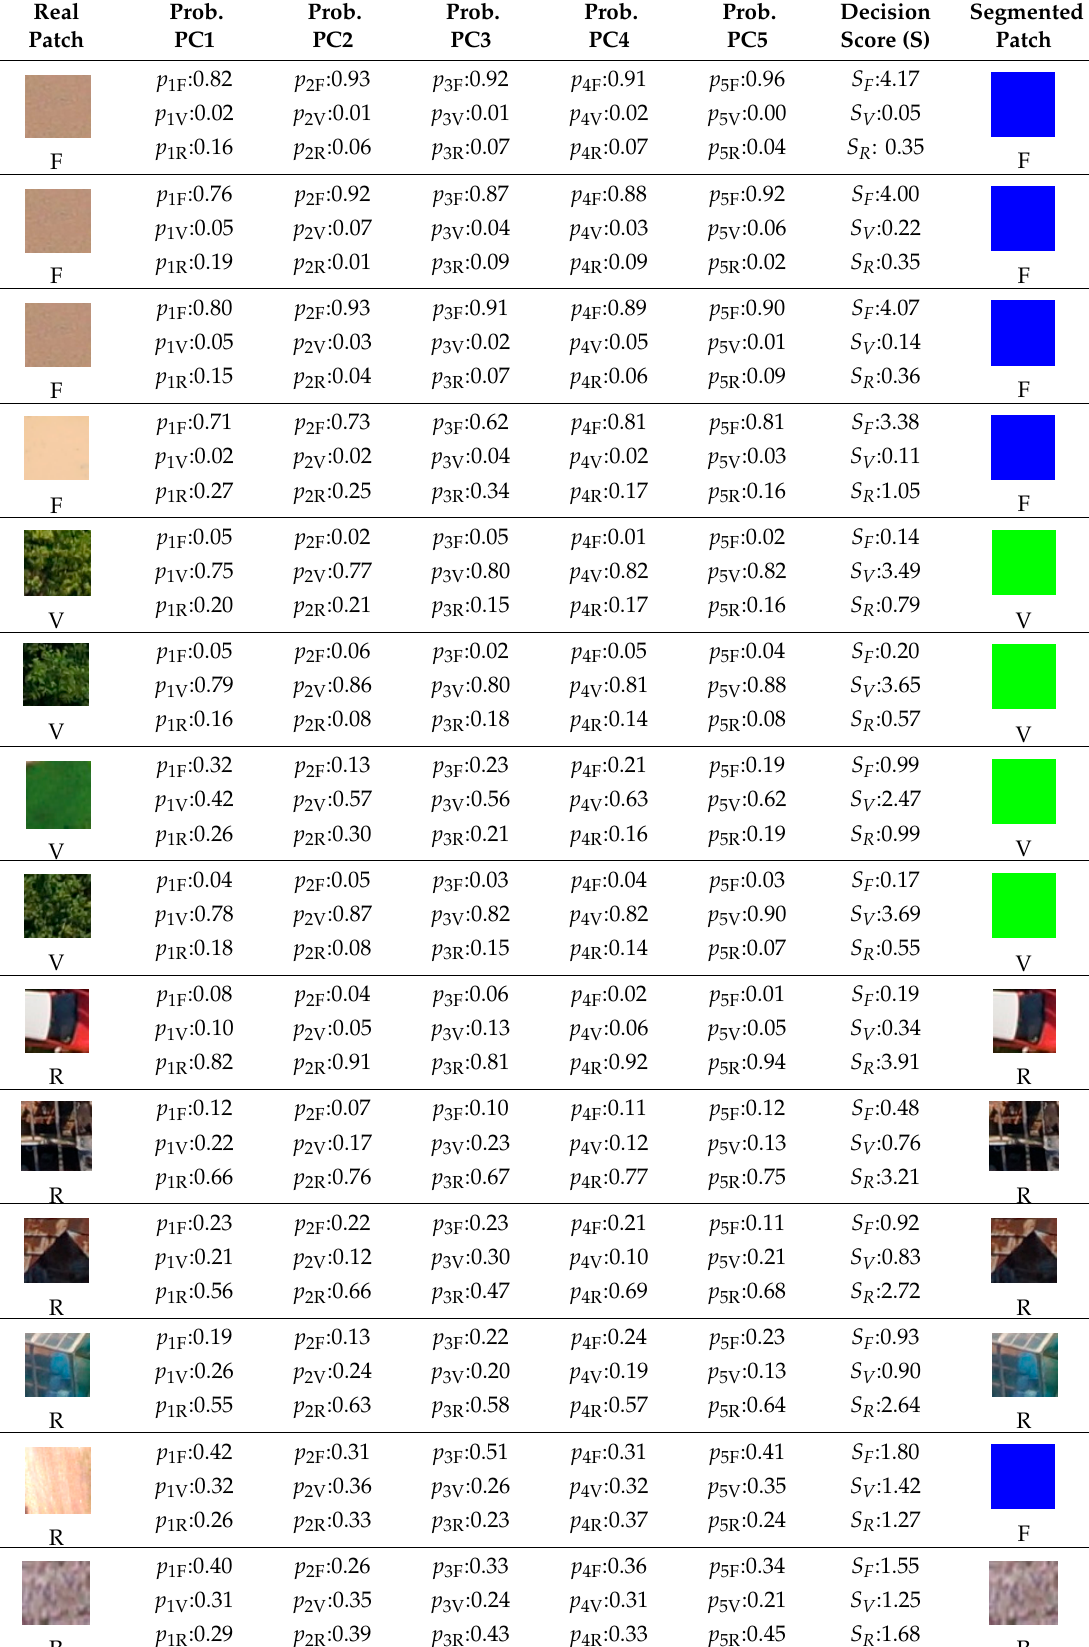
Real Real Patch